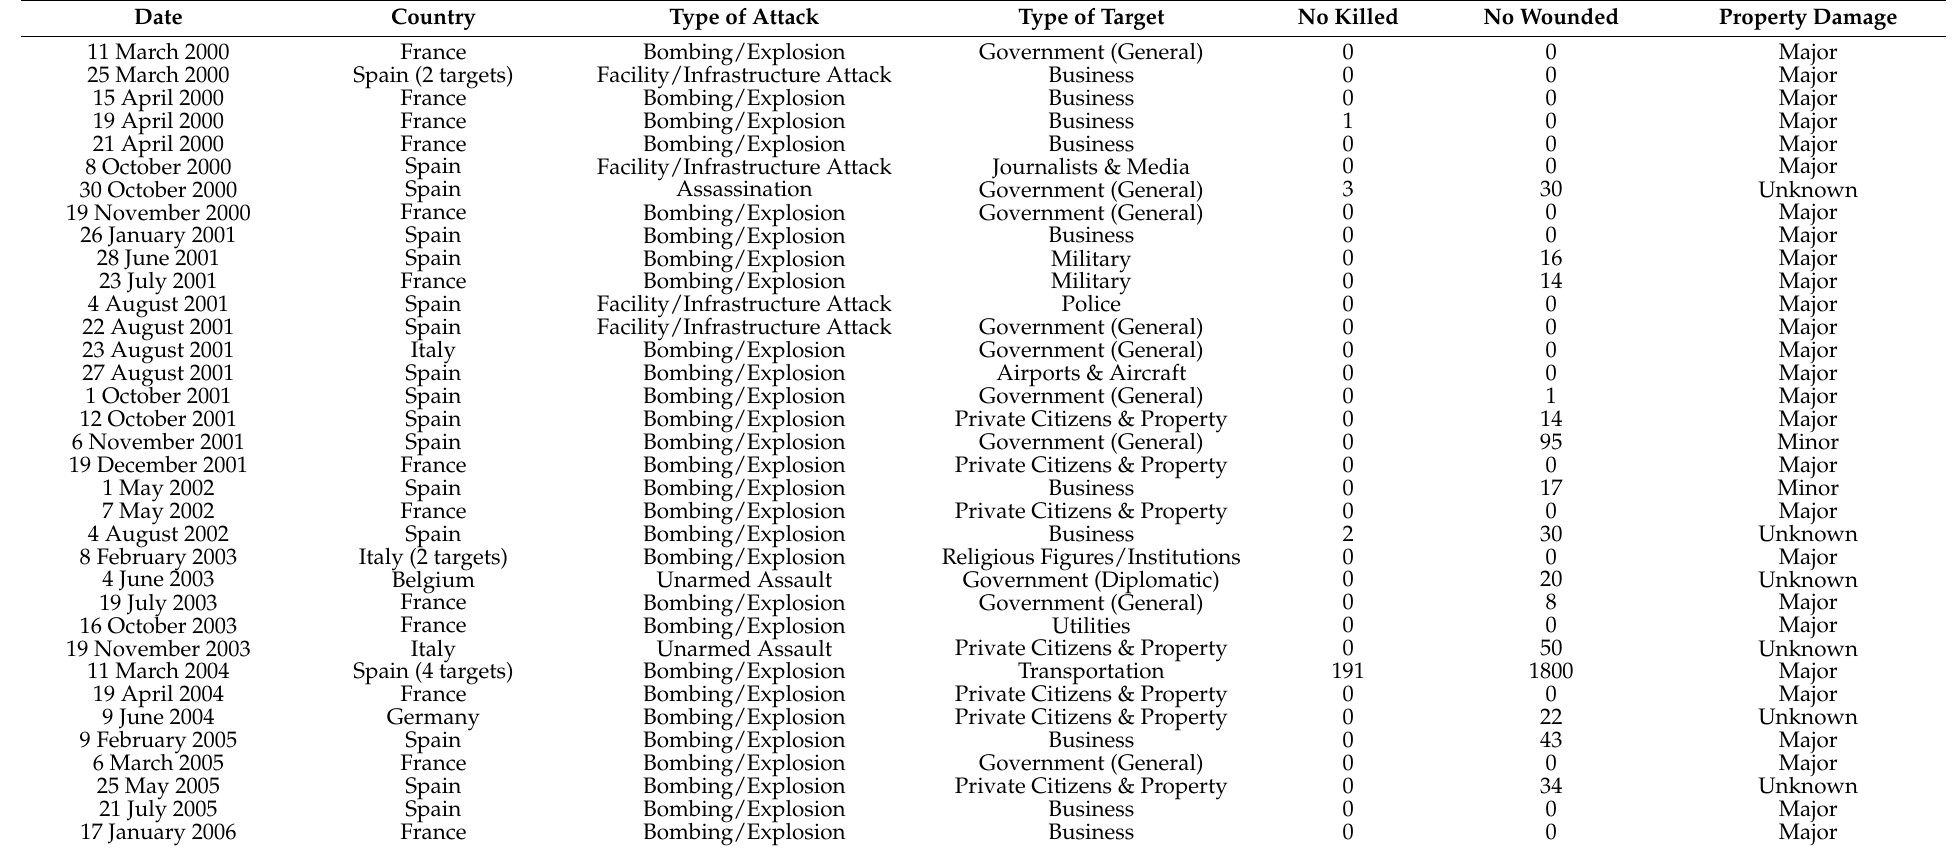
Table A1. List of all “event-days” in our